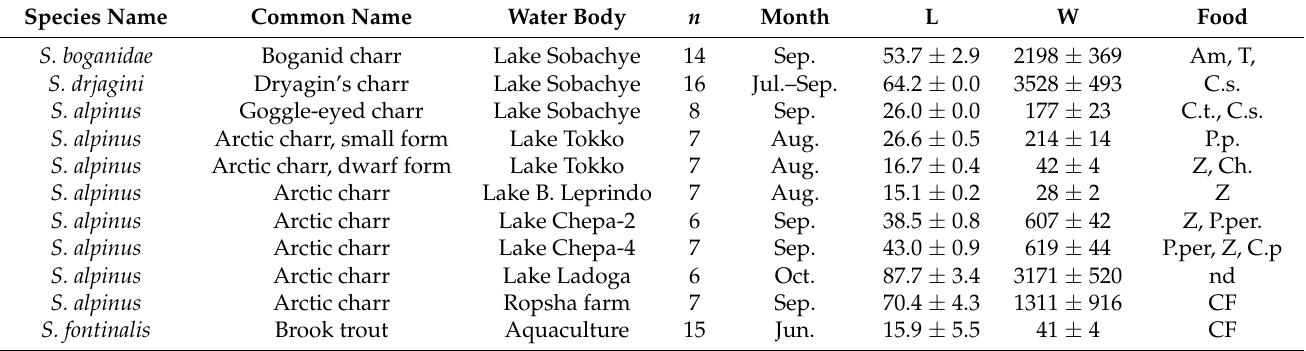
Table 2. The basic biological and sampling information on Salvelinus species from Russian